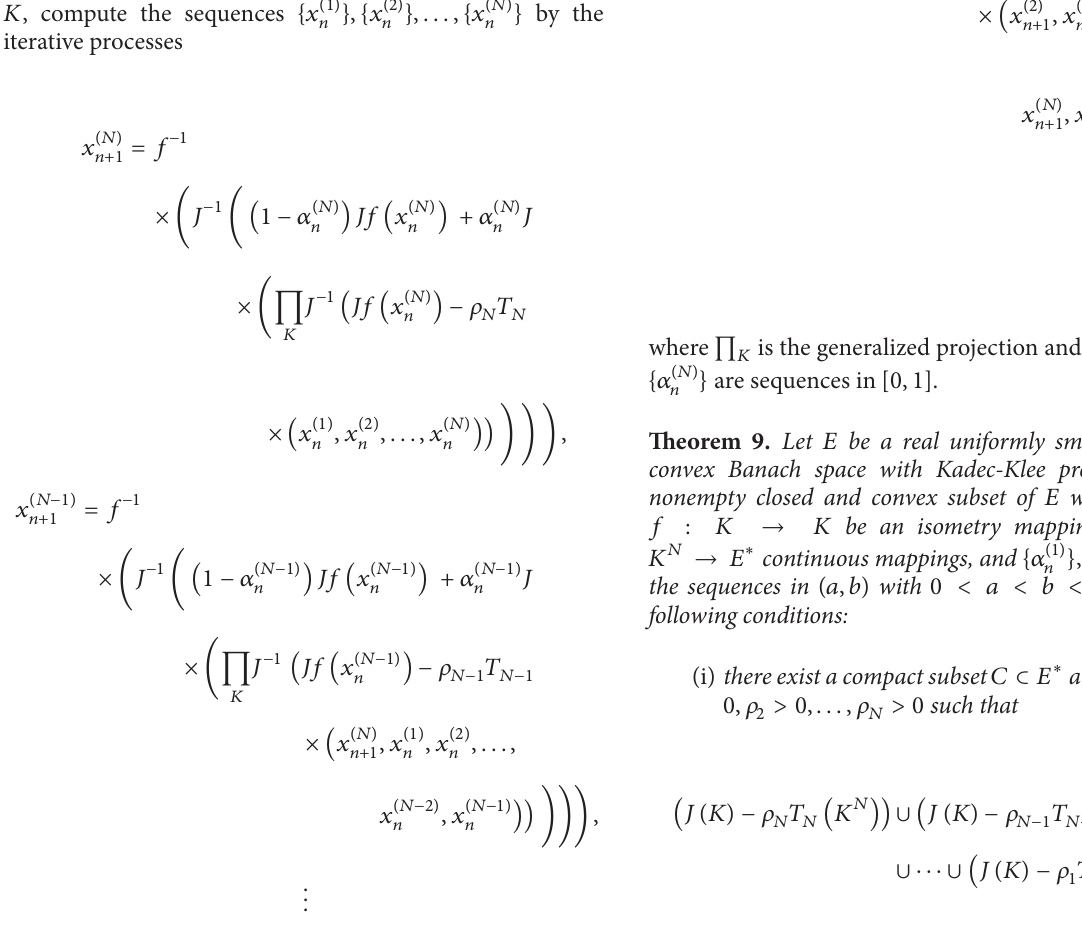
(1) , 𝑥 (2) , . . . , 𝑥 (𝑁) ∈ 0 0 0 }, {𝑥 (2) }, . . . , {𝑥 (𝑁) } by the 𝑛 𝑛 𝑛